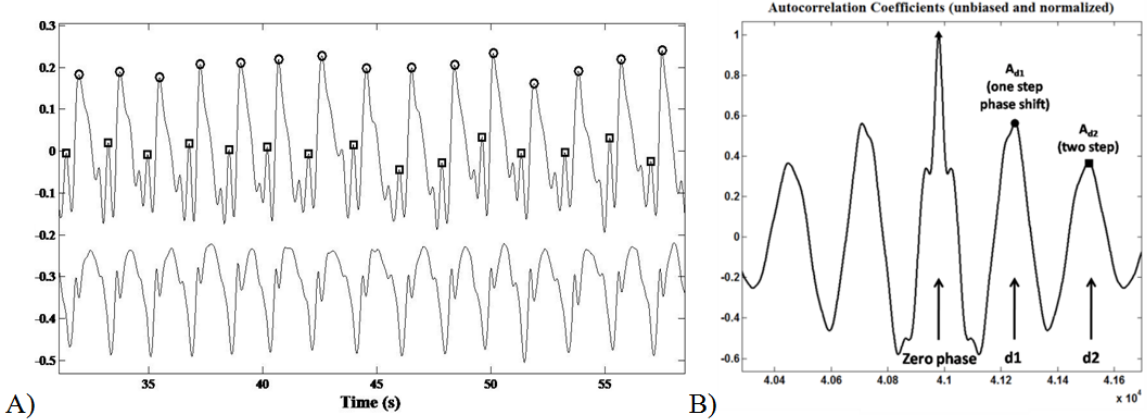
Figure 4. ( A ) Left-Right contact detection process. Round and square markers identified the left and right foot-ground contacts respectively, within the AP acceleration signal (upper line) in g. Peaks were discriminated on the basis of the local pattern of the ML signal (lower line) in arbitrary unit for data visualization; ( B ) Middle section of the unbiased and normalized autocorrelation sequence of vertical trunk acceleration during normal walking: d1 and d2 represent a phase shift of the first and the second step (of the contralateral limb),